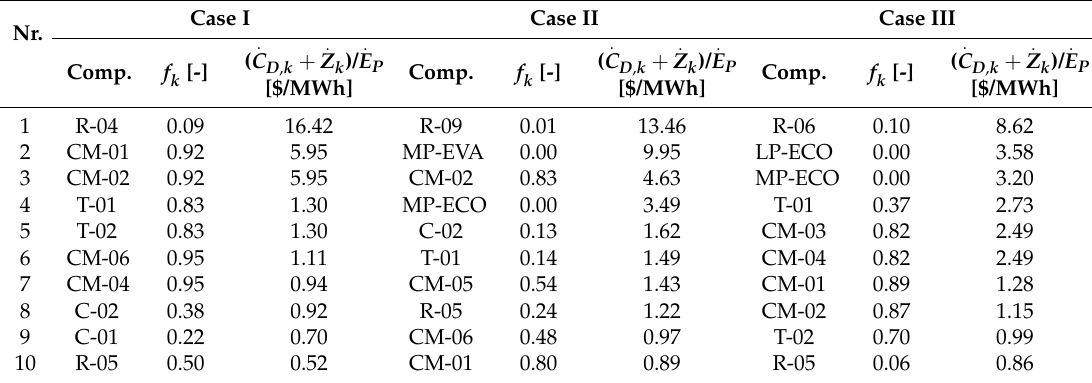
Table 6. Comparison of the cases using results from the exergoeconomic analyses. Case I Case II Case III Nr.